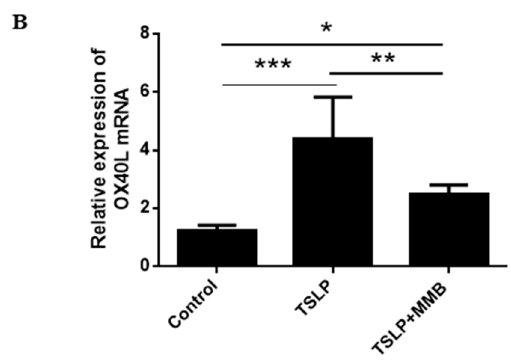
Figure 6. Effect of MMB on costimulatory molecules and OX40L in TSLP-induced dendritic cells (DCs). ( A ) The expression of CD11C, CD80, CD86, and MHCII. Values are mean ± SD ( n = 3). * p < 0.05, ** p < 0.01, *** p < 0.001 versus 0 MMB group. ( B ) The relative mRNA expression of OX40L. Values are mean ± SD ( n = 5). * p < 0.05, ** p < 0.01, *** p < 0.001 .